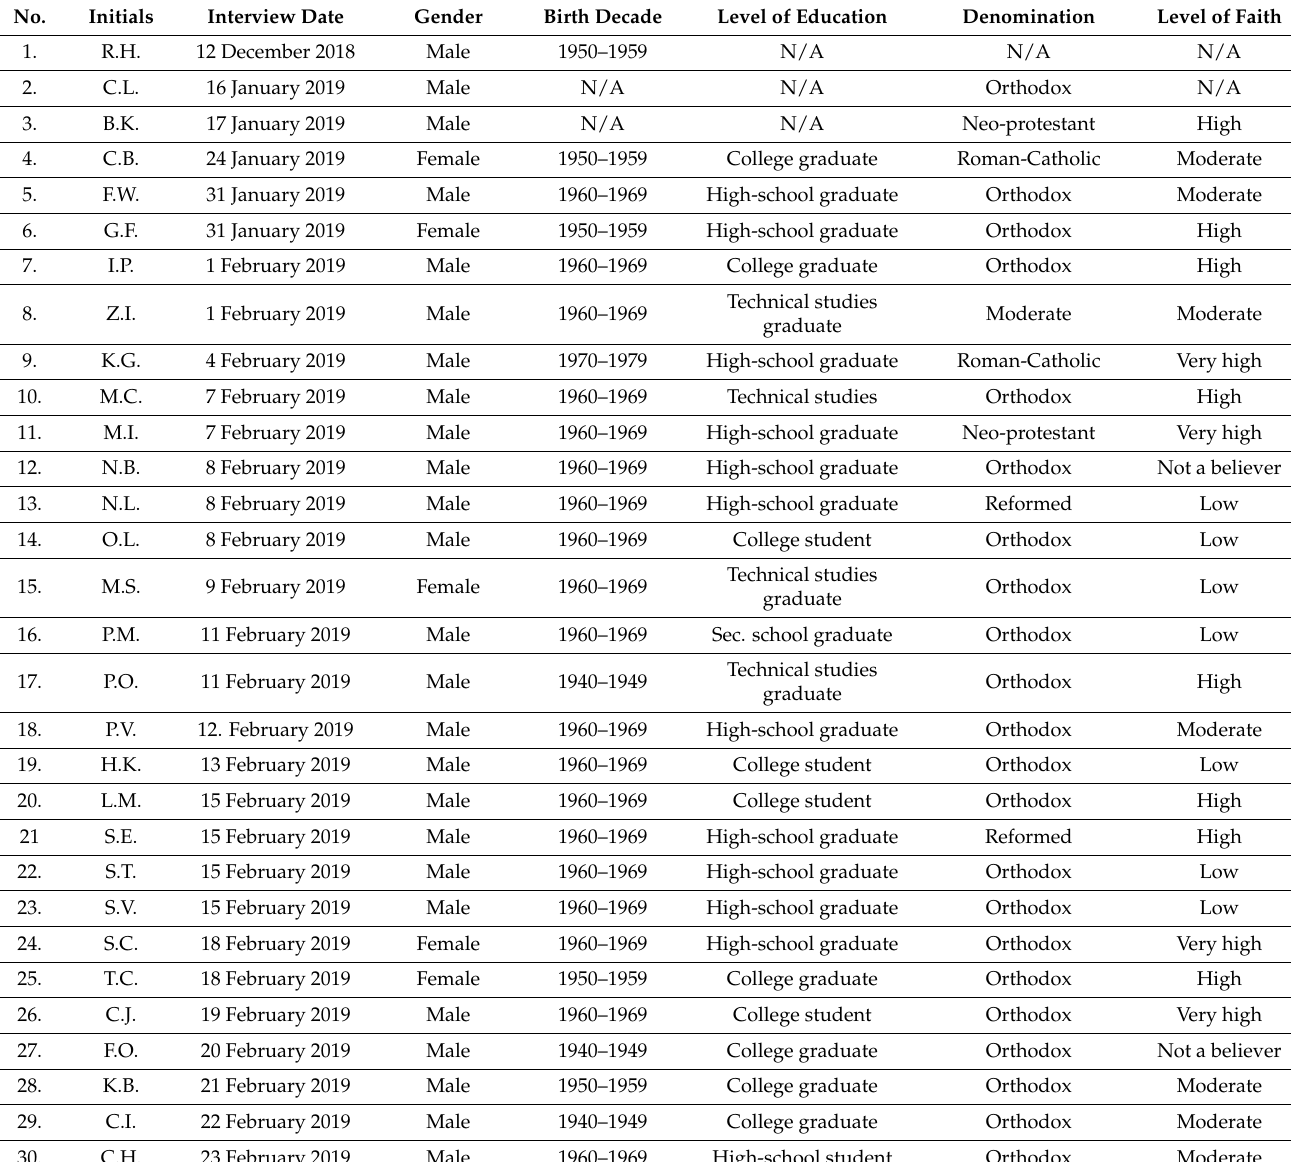
Table 1. An overview of the respondents’